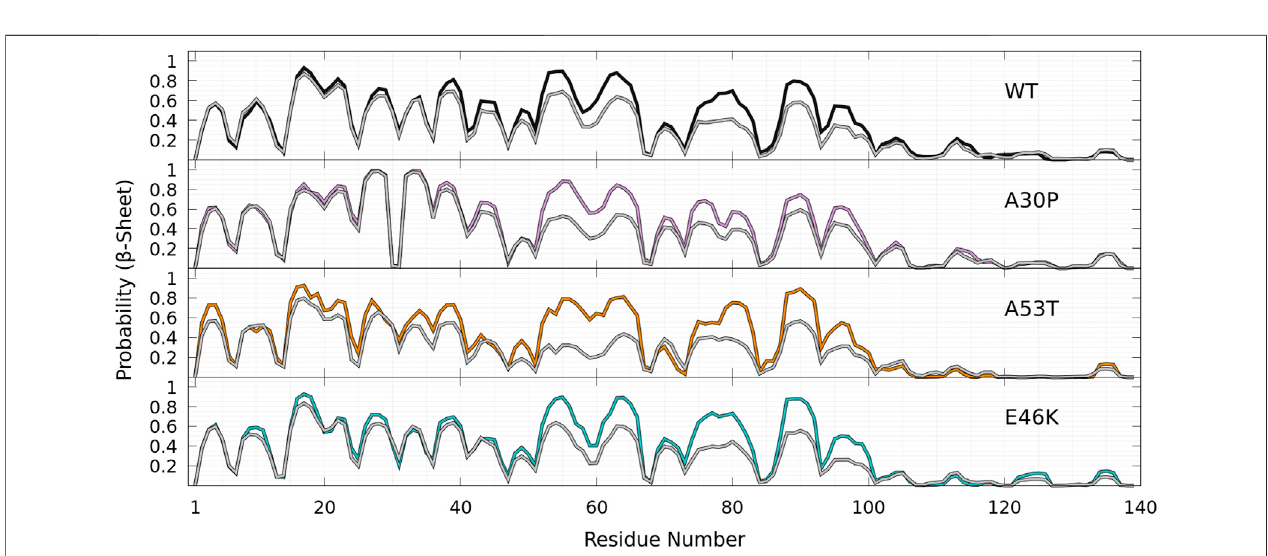
FIGURE 9 | Probability of each residue to pertain to a β -sheet for WT (black), A30P (purple), E46K (turquoise), and A53T (orange) in the B state compared to the probability in the corresponding entire (B + HB) ensemble of conformations for each protein (gray) as a function of the residue position in the sequence.